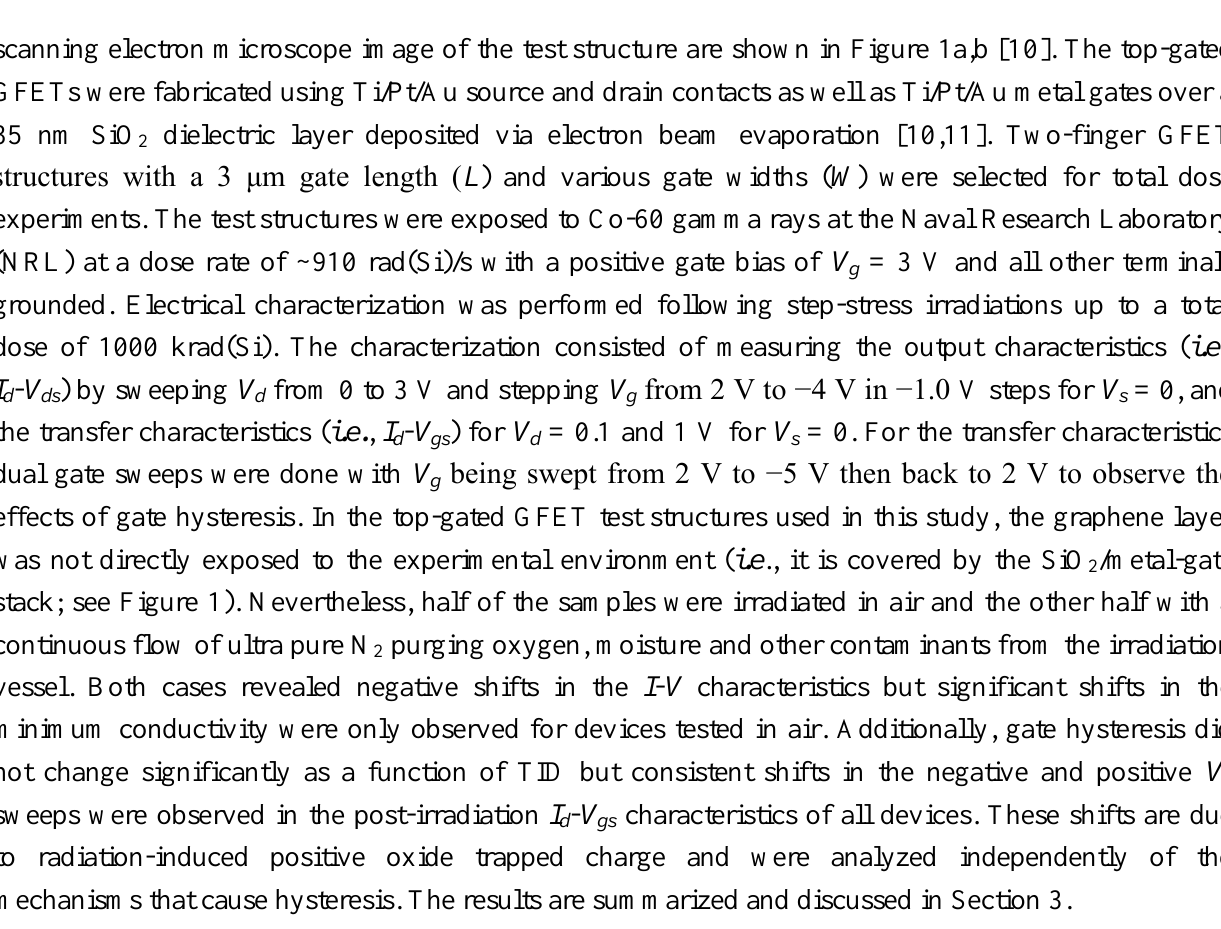
Figure 1. ( a ) Schematic diagram of top-gated graphene FET (GFET) fabricated with epitaxial graphene layers grown on Si-face 6H-SiC substrates via Si sublimation; ( b ) Scanning electron microscope (SEM) image of the GFET test